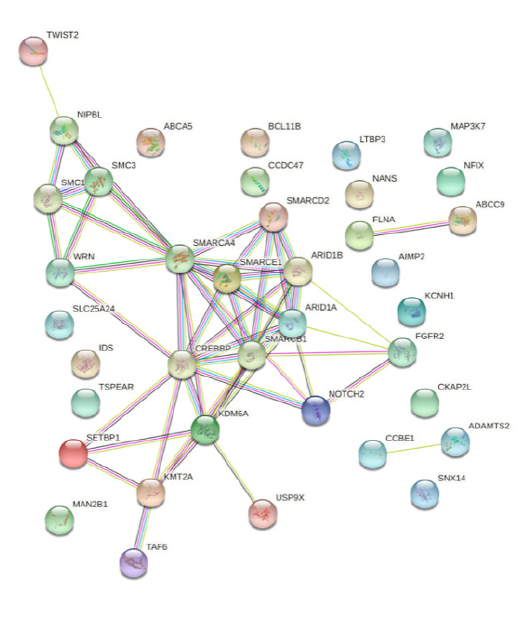
Figure 1. Protein-protein interaction network with the genes associated with syndromes with hypertrichosis and dental anomalies. Nineteen out of 38 genes formed a node including ARID1A , ARID1B , CREBBP , FGFR2 , KDM6A , KMT2A , NIPBL , NOTCH2 , SETBP1 , SMARCA4 , SMARCB1 , SMARCD2 , SMARCE1 , SMC1A , SMC3 , TAF6 , TWIST2 , USP9X , and WRN (p < 1.0e-16). Different colors represent different levels of evidence of connection between proteins. Light blue represents curated databases, purple experimental evidence, green gene neighborhood, red gene fusions, blue gene co-occurrence, light green evidence from text mining, black co-expression, and violet protein homology. This analysis had an average confidence score of 0.472, suggesting a low rate for false- positive interactions.